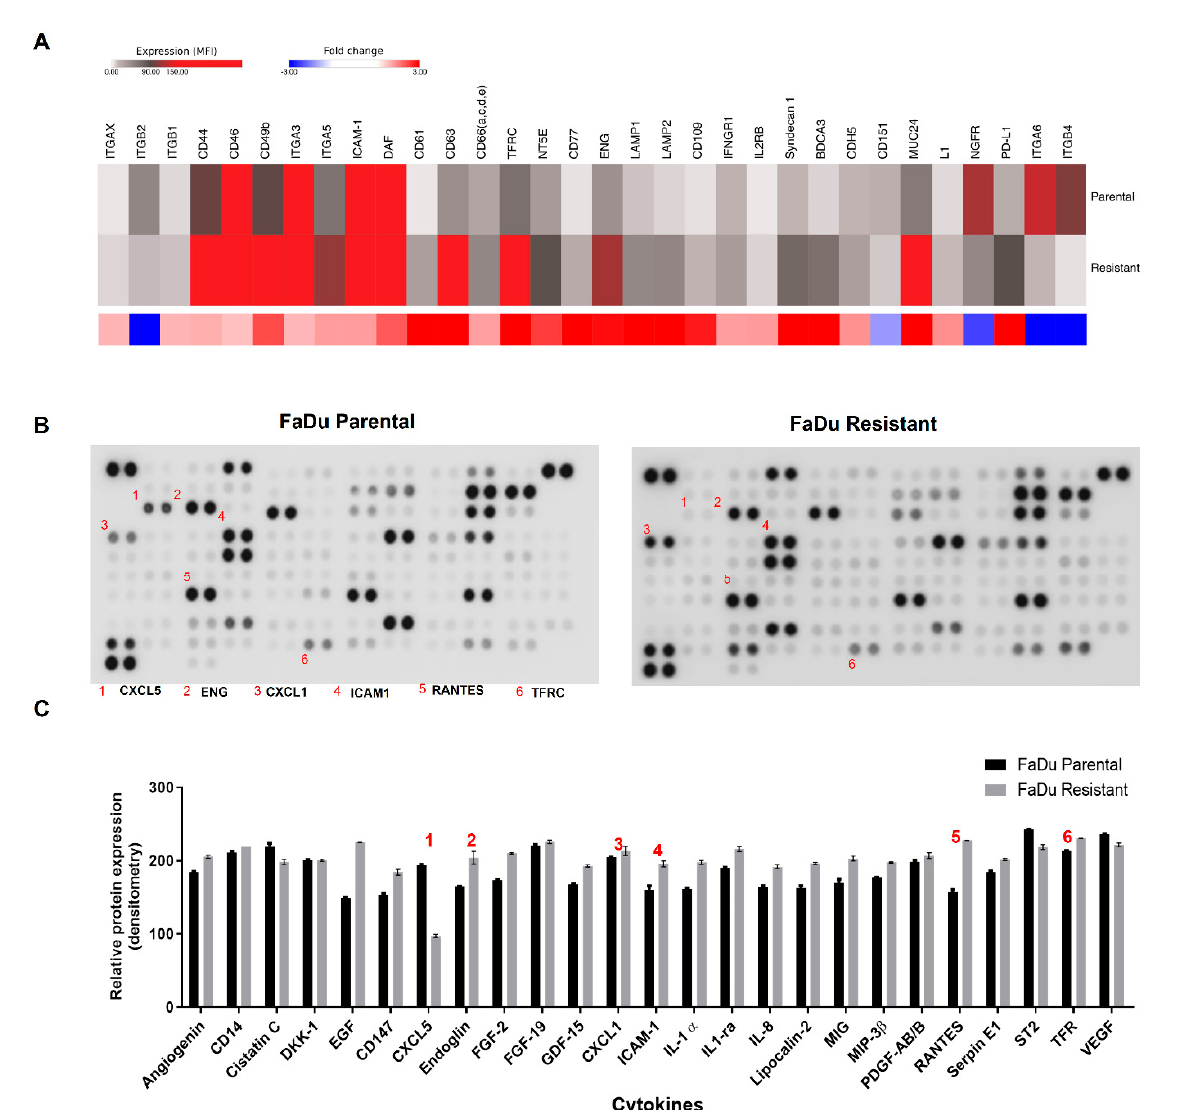
Figure 4. Cell surface markers and cytokines profile expression in FaDu parental and FaDu resistant cells. ( A ) Representation of cell-surface markers expression in FaDu parental and FaDu resistant cells. p. adjusted < 0.01. ( B ) Representative images of Cytokines protein array in FaDu parental and FaDu resistant cells. ( C ) Bars demonstrated the cytokines differential expression in FaDu cells.